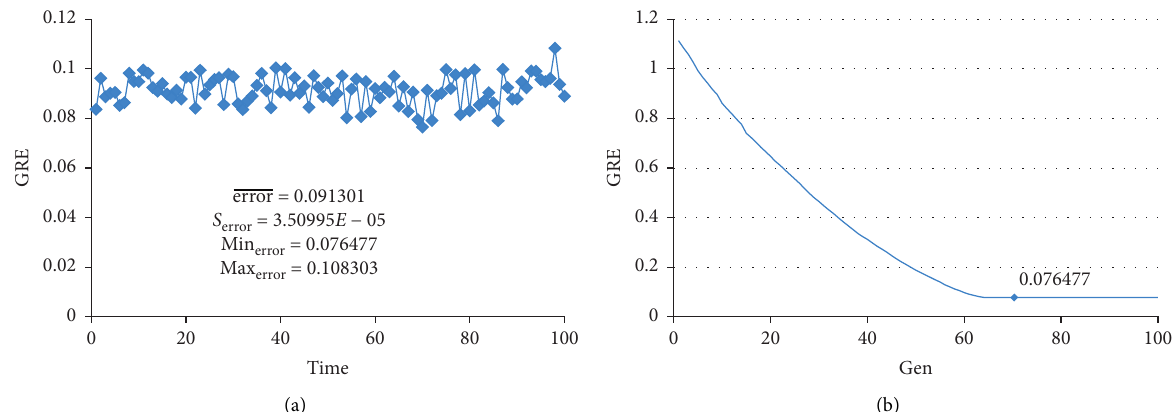
Figure 16: (a) The statistics of GREs in 100 simulations. (b) The iterations of DULAEM.